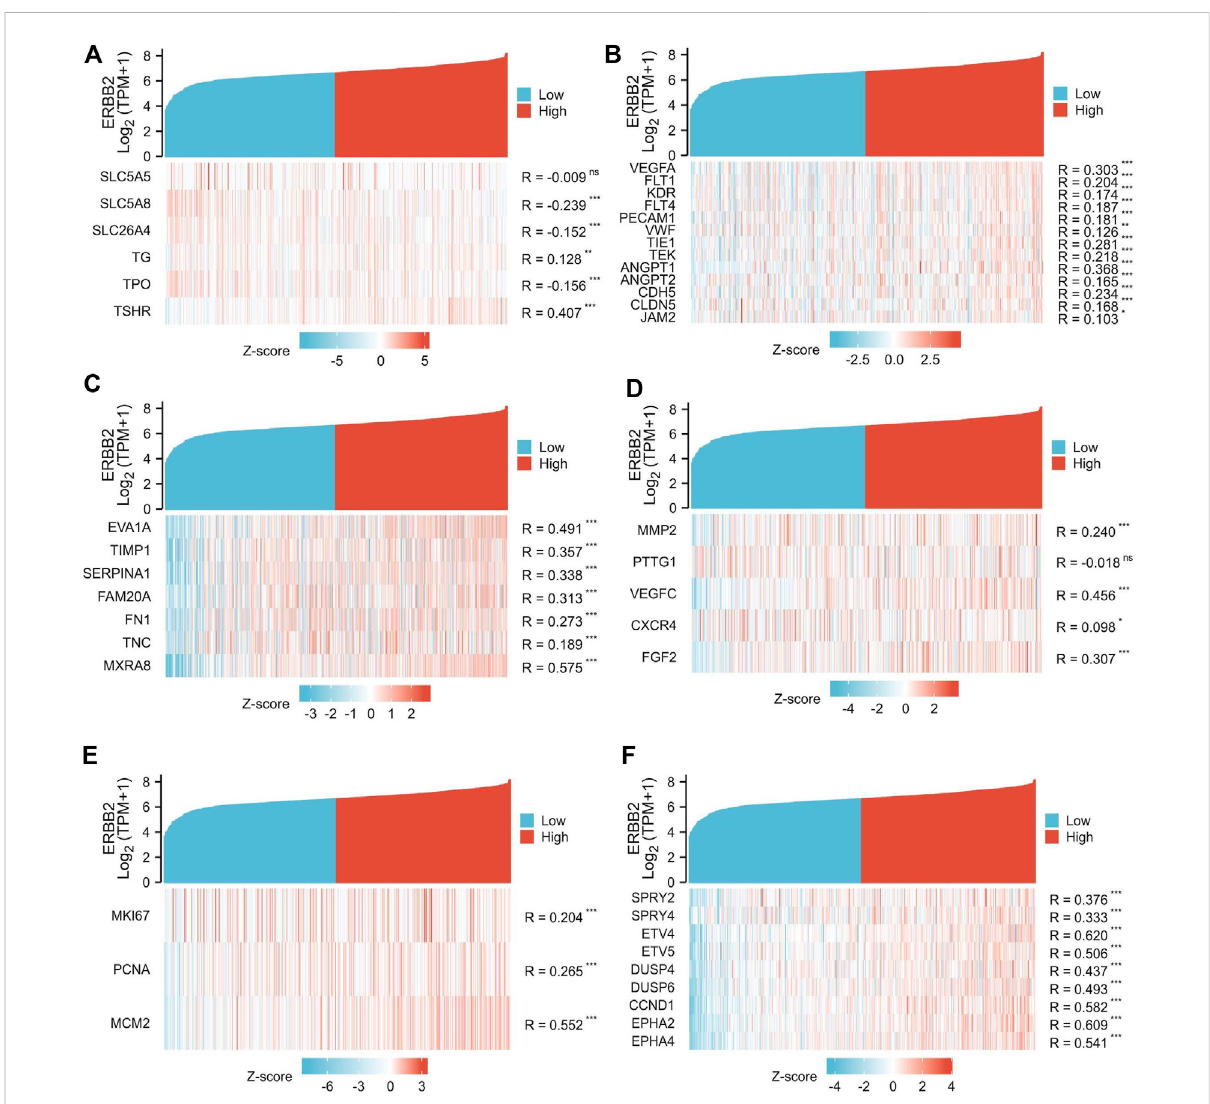
FIGURE 4 Co-expression analysis of ERBB2 and genes related to unfavorable thyroid cancer phenotypes. (A) the expression of ERBB2 is negatively correlated with iodine metabolism genes of SLC5A8 , SLC26A4 , and TPO . (B) the expression of ERBB2 was positively correlated with the tumor angiogenesis gene set. (C) the expression of ERBB2 is positively correlated with the gene set of lymph node metastasis. (D) the expression of ERBB2 was positively correlated with the distant metastasis gene set. (E) the expression of ERBB2 was positively correlated with the gene set of cell proliferation. (F) the expression of ERBB2 was positively correlated with the MEK inhibitor resistance gene set. * p < 0.05, ** p < 0.01, *** p <